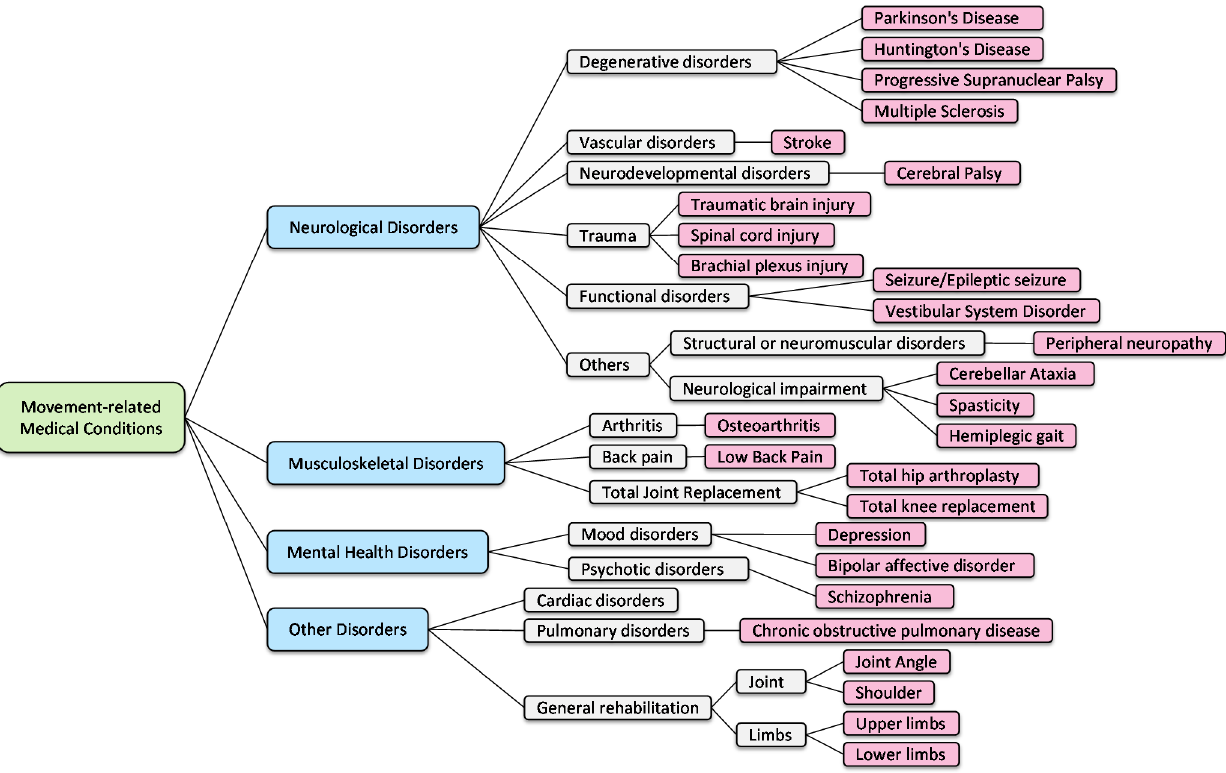
Figure 2. A taxonomy of the selected